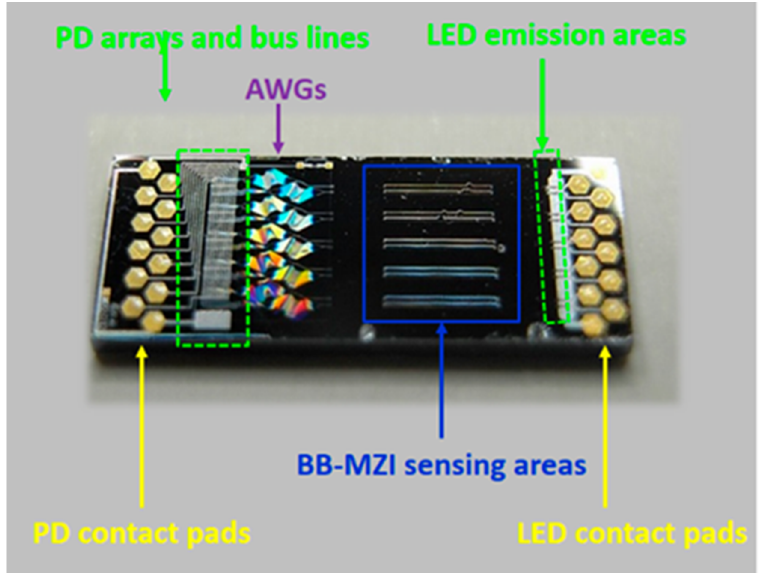
Figure 4. Photograph of the fully integrated spectroscopic chip: broadband Mach–Zehnder interfer- ometers (BB-MZIs, blue rectangle), the arrayed waveguide gratings (AWGs, purple arrow). The light sources (LED) and photodiodes (PDs) (green rectangles) are connected to the electrodes. Adapted with permission from [299]. Copyright (2020) American Chemical Society.